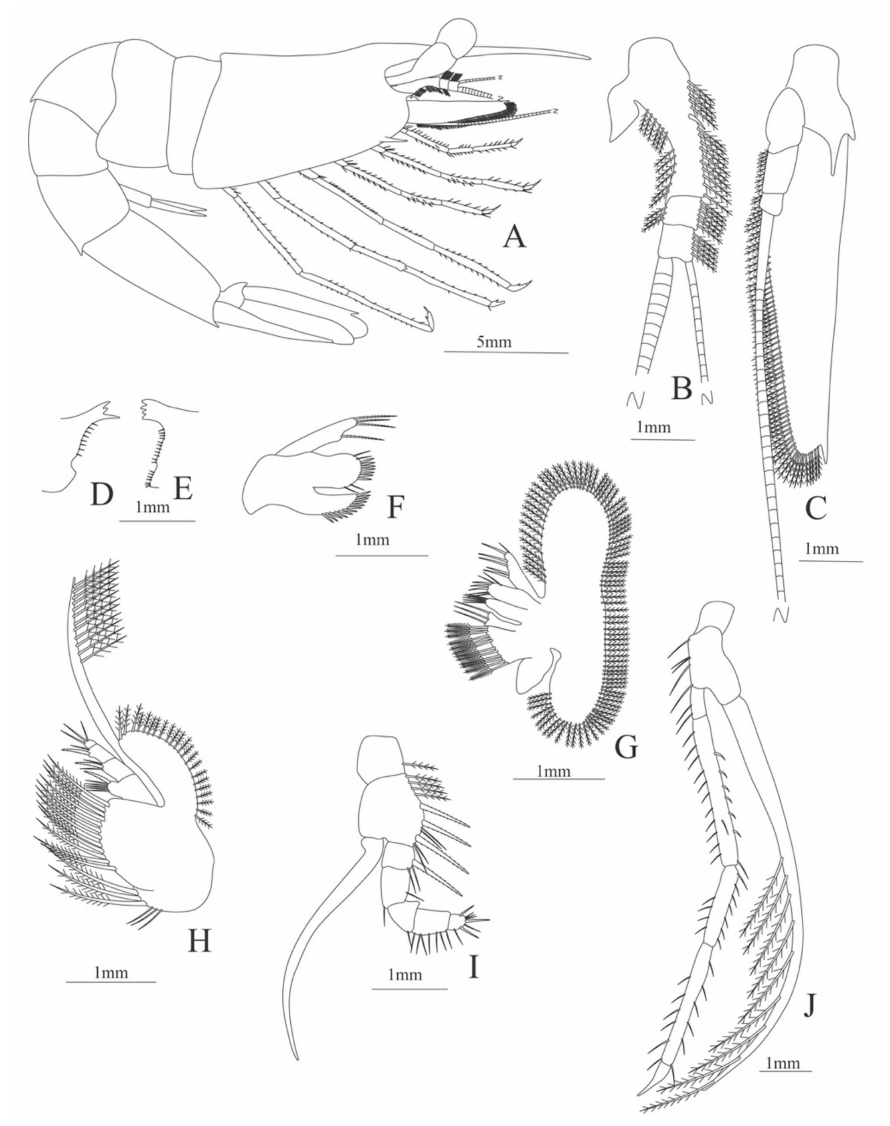
Figure 21. Plesionika edwardsii : ( A ) lateral view; (B ) antennule; ( C ) antenna; ( D ) left mandible (cutting edge); ( E ) rigth mandible (cutting edge); ( F ) maxillule; ( G ) maxilla; ( H ) first maxilliped; ( I ) second maxilliped; ( J ) third maxilliped. Uropods (Figure 22F). Endopod well developed with 96 plumose setae; exopod, with 84 plumose setae Telson (Figure 22G) elongate, subtriangular, with three pairs of lateral spines; distally with one central large spine and 3 pairs of small spines and one spine on each